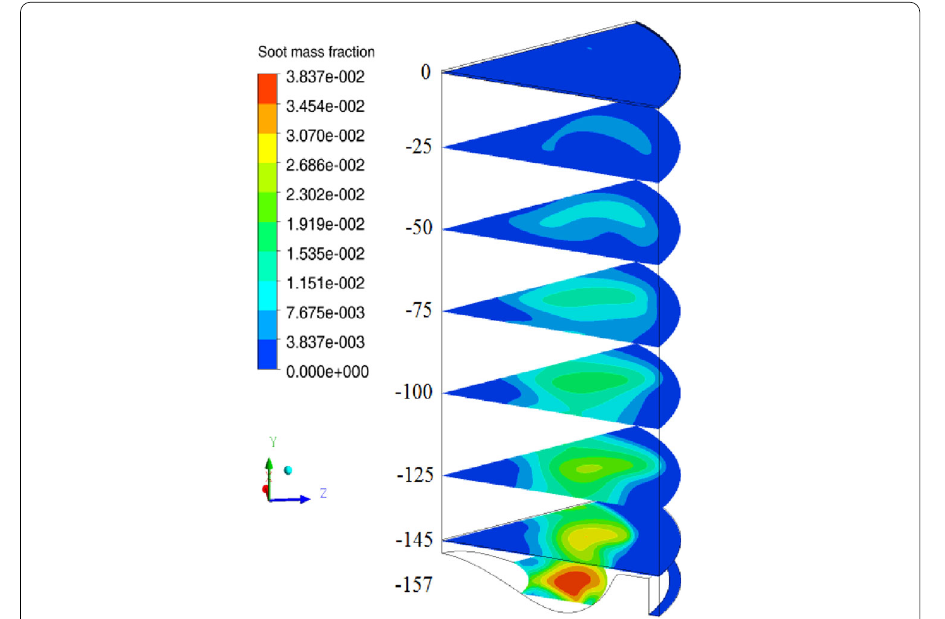
Fig. 7 Contours of soot mass fraction at 833 ◦ CA (scale in figure is in milimeters)